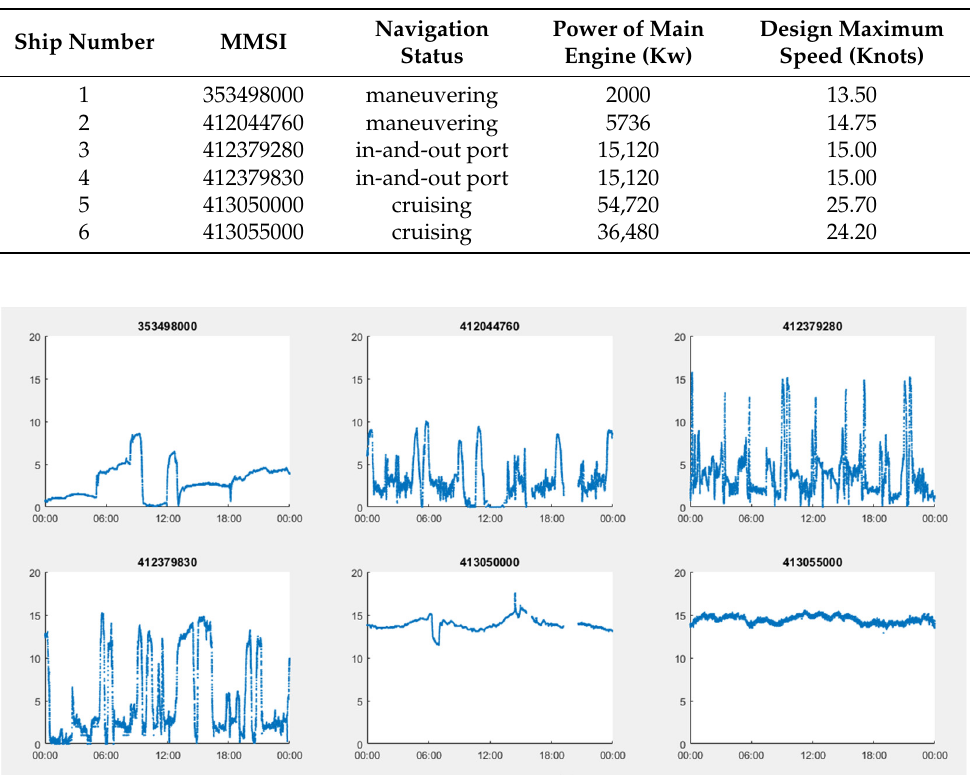
Table 1. Information on the sampled ships.